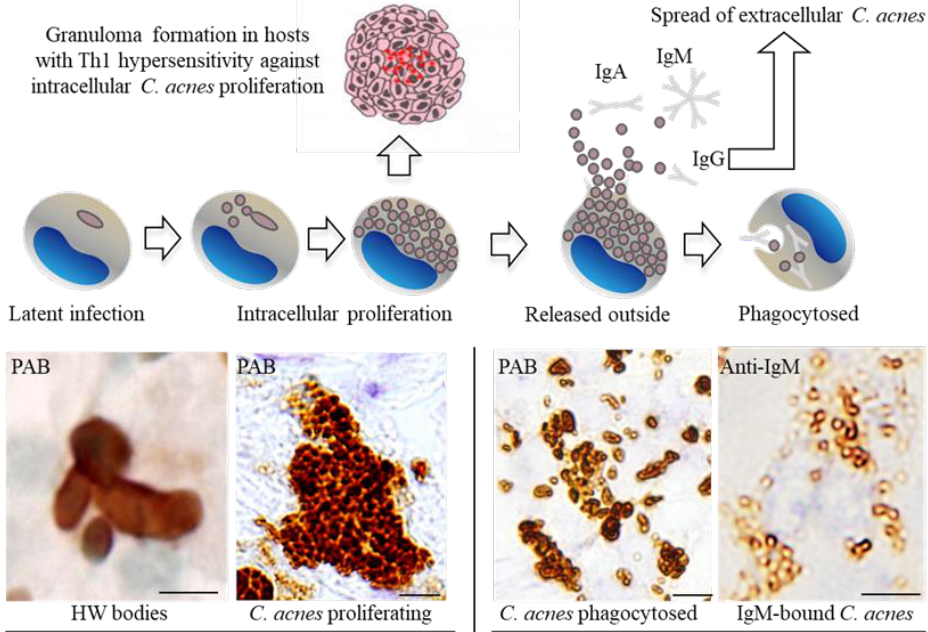
Figure 4. Granuloma formation against the intracellular proliferation of latent C. acnes in susceptible hosts and insoluble immune-complex formation with extracellular C. acnes outside granulomas after rupture of the infected cells. Representative immunohistochemical features detected by PAB and anti-IgM antibodies are shown below the illustrated macrophages with each stage of intracellular C. acnes manifestation. All photos are original and were previously published [35]. Scale bar: 5 µ m. HW,